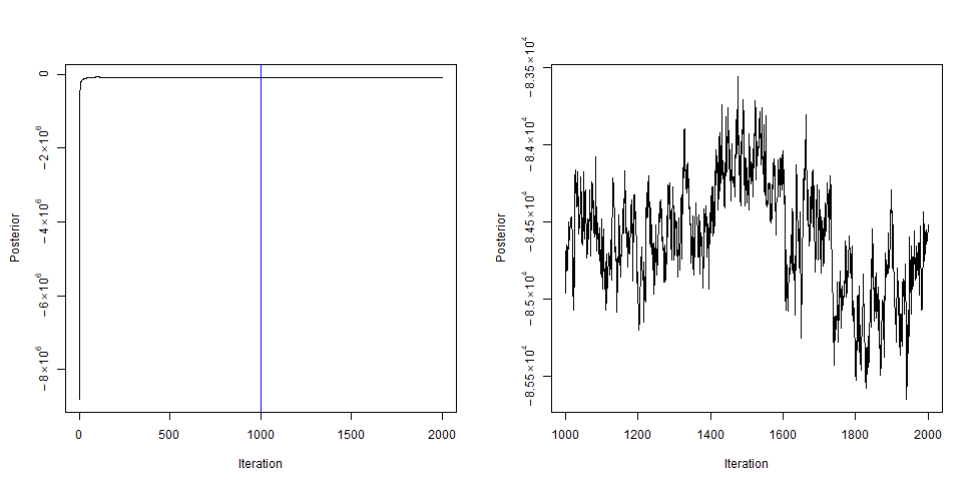
Figure 1. Posterior ( left ) when the observation was drawn. The plot on the right -hand side focuses on the last 50% of observations after the